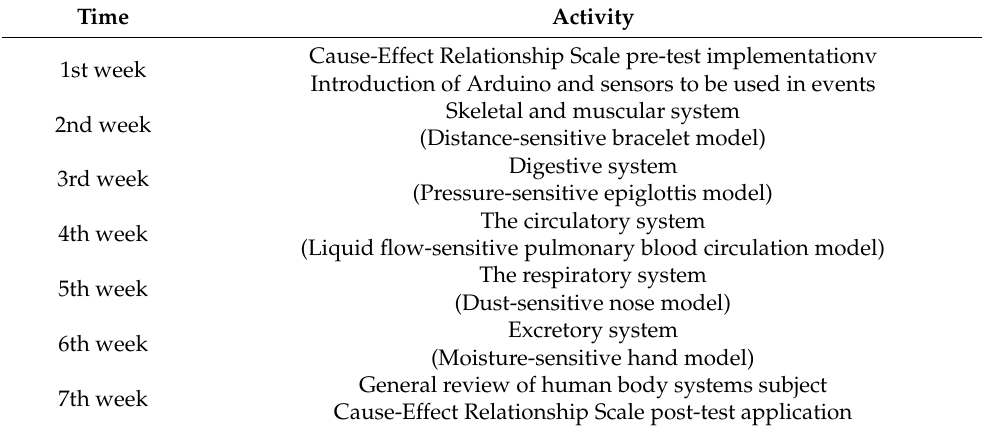
Table 4. Activity Implementation